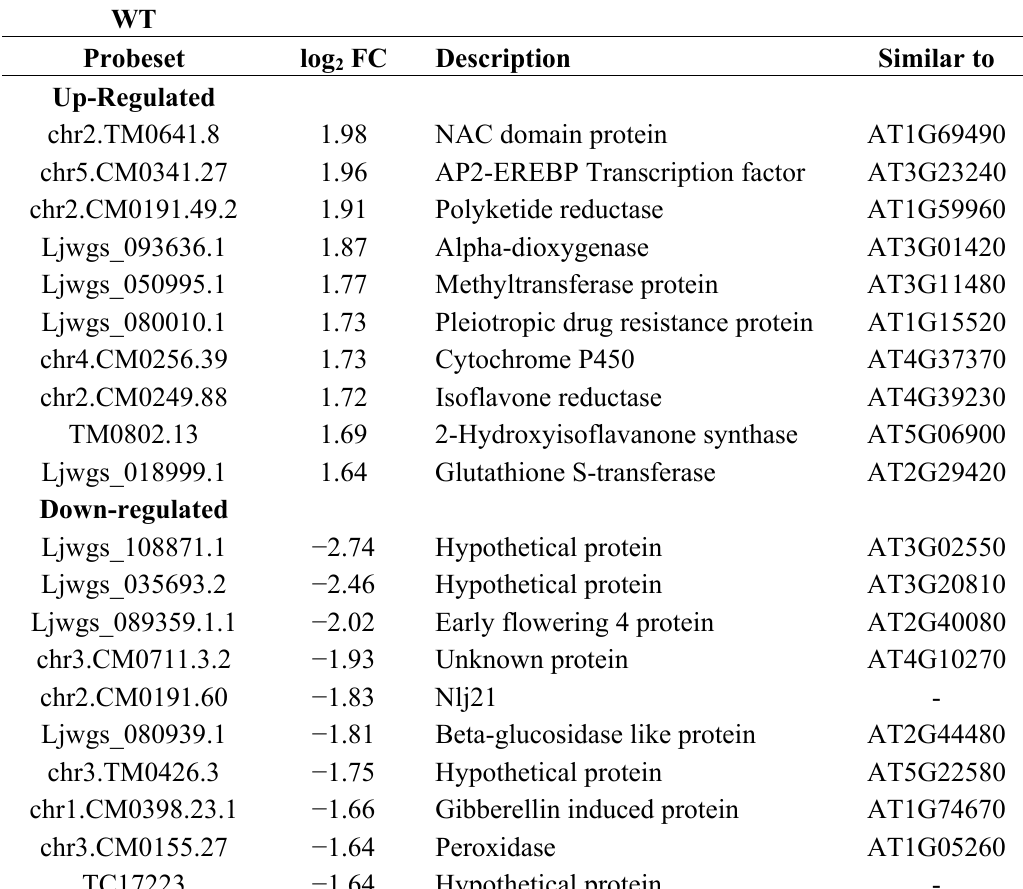
Table 2. Top 10 genes up- or down-regulated by active photorespiration in WT and Ljgln2-2